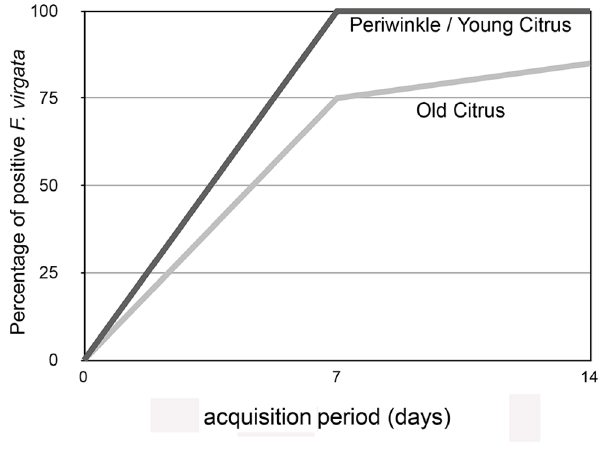
Figure 2. Average Ct values of Ferrisiavirgata that fed for two weeks on ‘ Candidatus Liberibacter asiaticus’ (Las) infected leaf discs and moved to non-infected leaf discs. For each sample day, means 6 SE followed by different letters are significantly difference (P , 0.005) using Student’s t-test.